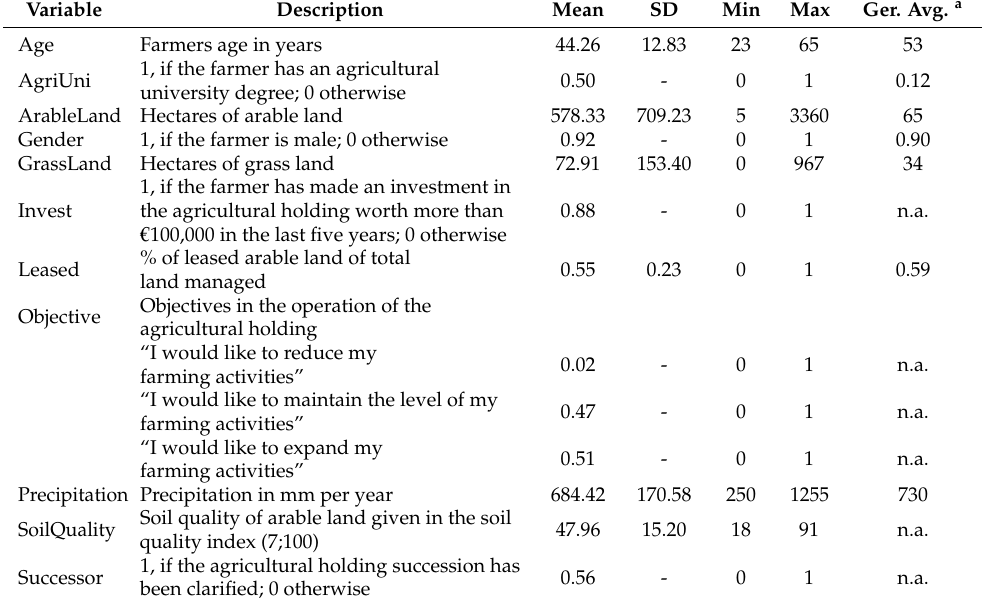
Table 3. Descriptive statistics (N =